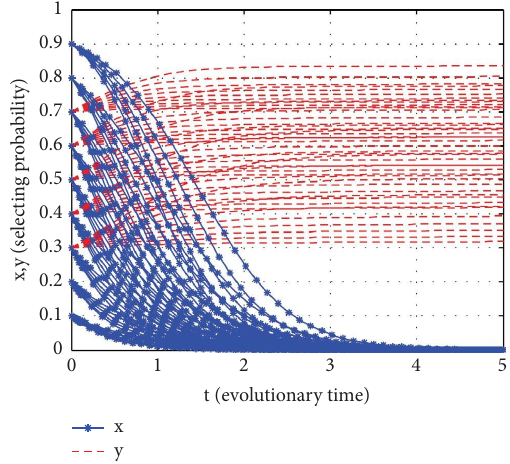
Figure 4: Te evolutionary consequences of Proposition 2